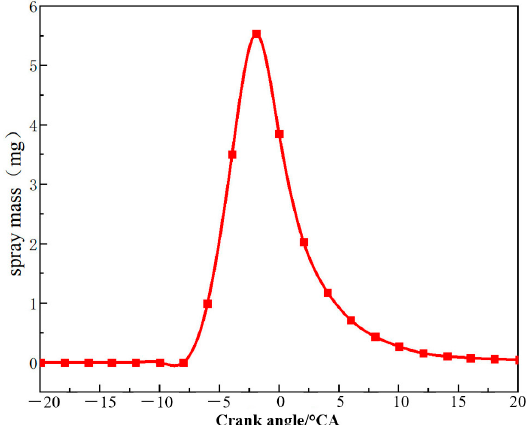
Figure 9. Variation of fuel vapor mass in a cylinder with crankshaft angle.